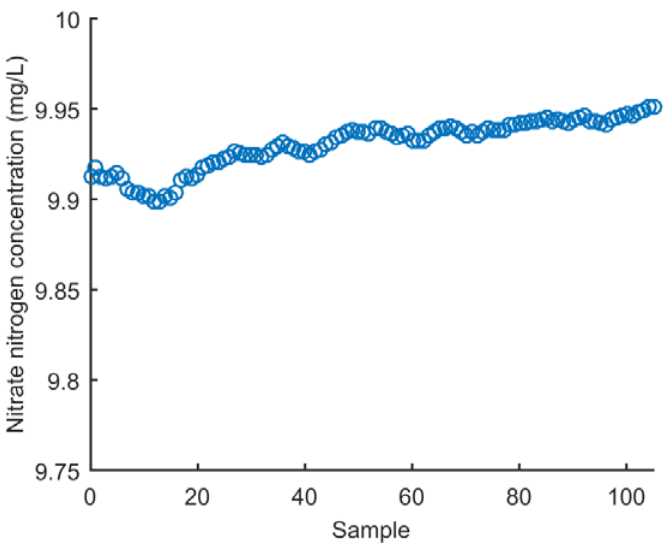
Figure 10. Repeatability of the measurements.